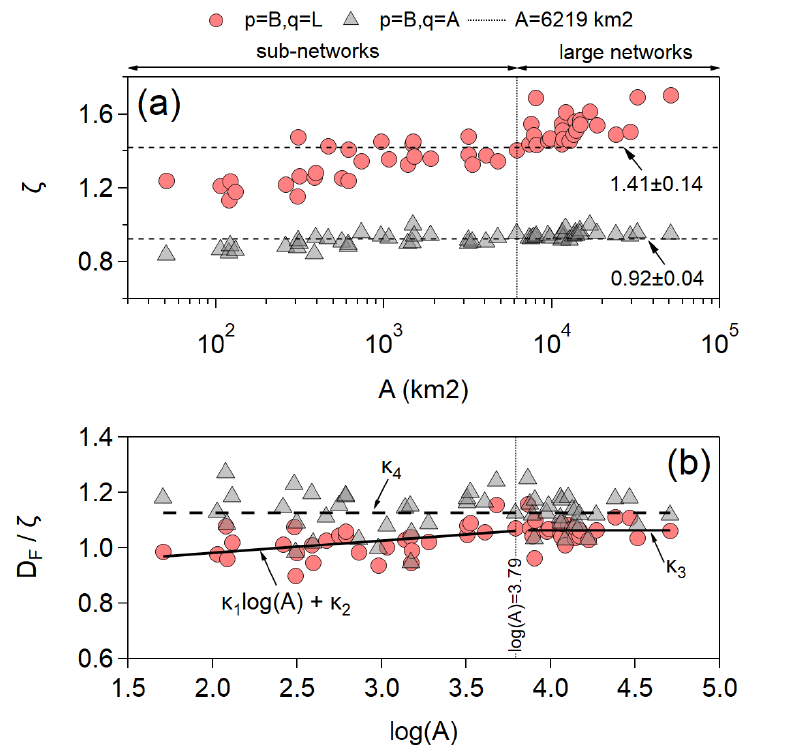
Figure 9. ( a ) Comparison between ζ and drainage area A for large and sub-networks. Here p = B and q = A , L and the vertical line is A = 6219 km 2 . The averages ¯ ζ = 1.41 ± 0.14 for q = L and ¯ ζ = 0.92 ± 0.04 for q = A were included for reference (horizontal dashed-lines). ( b ) Comparison between D F / ζ and log ( A ) for all networks. Continuous lines represent linear fits to